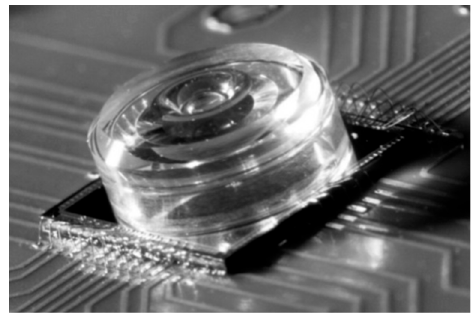
Figure 16. Lens mounted on top of the opto-ASIC.